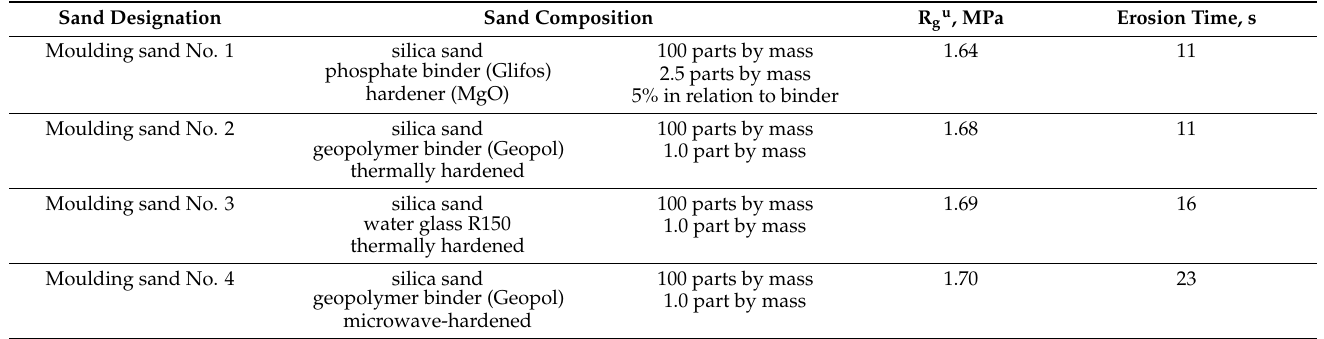
Table 1. Composition and parameters of the test sand mixtures.